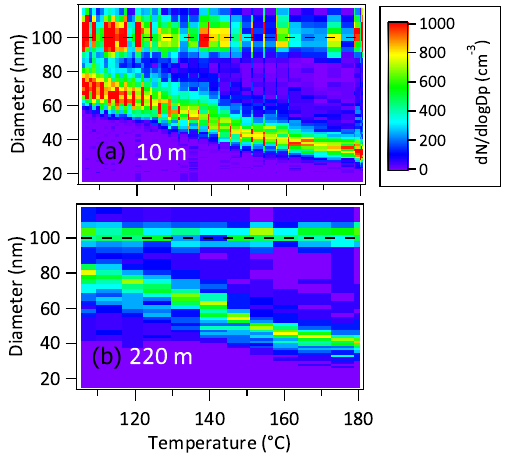
Figure 5. Similar to Fig. 3 showing average volatility spectra of 100nm particles at 10 and 220m downwind of the highway. Mea- surements were collected during transect runs in